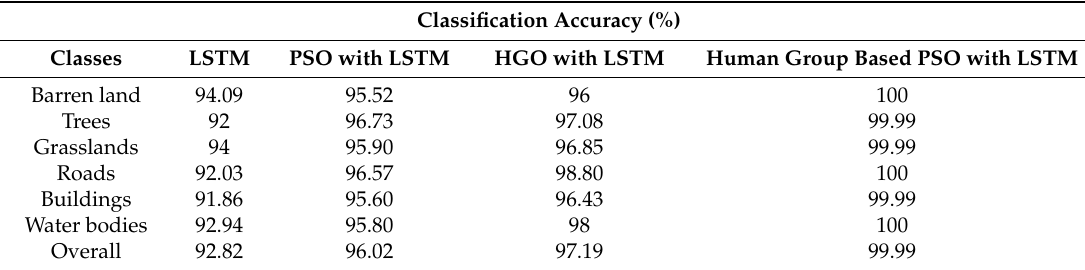
Table 12. Performance investigation of the proposed model with di ff erent optimization techniques on Sat 6 dataset by means of classification